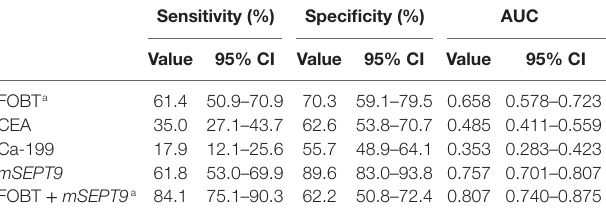
TaBle 3 | Diagnostic efficiency of each method in CRC detection.